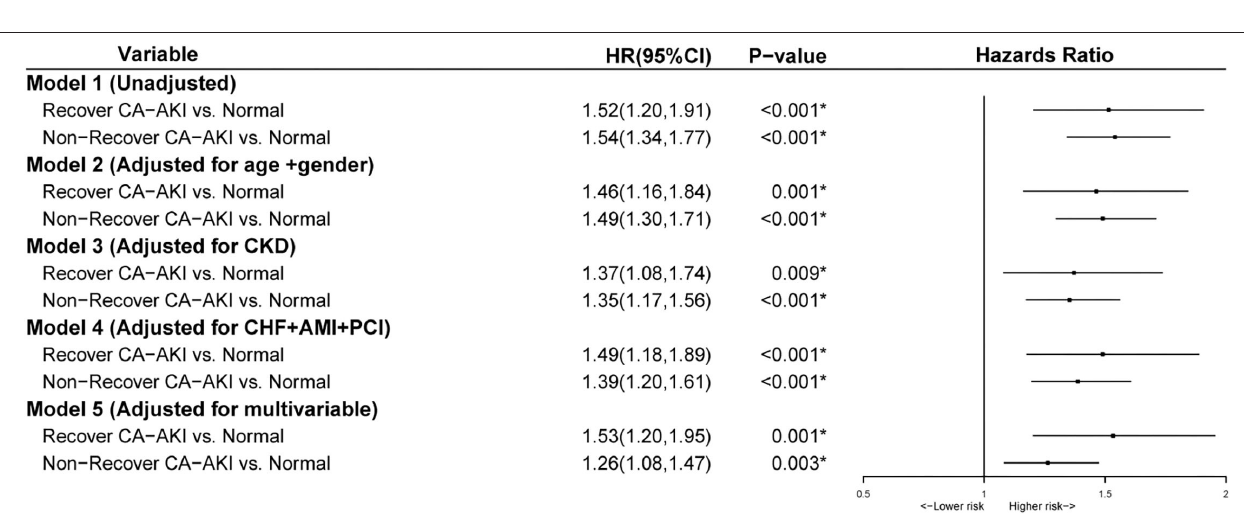
no CA-AKI patients, non-recovered CA-AKI patients have a higher incidence of chronic heart failure ( Table 1 ). This is